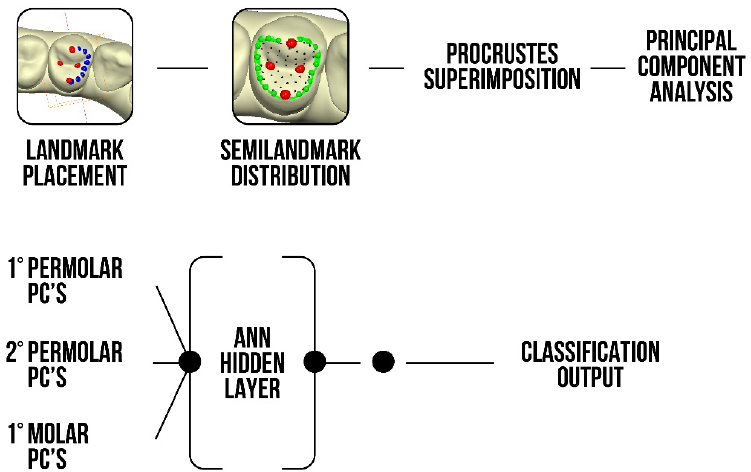
Figure 3. Outline of the study starting from the positioning of the landmarks and semi-landmarks up to the ANN output. PC: principal